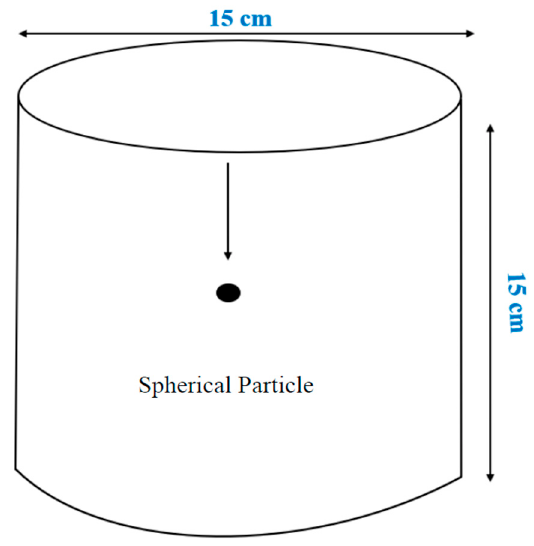
Figure 1. Unconfined fracture fluid system.